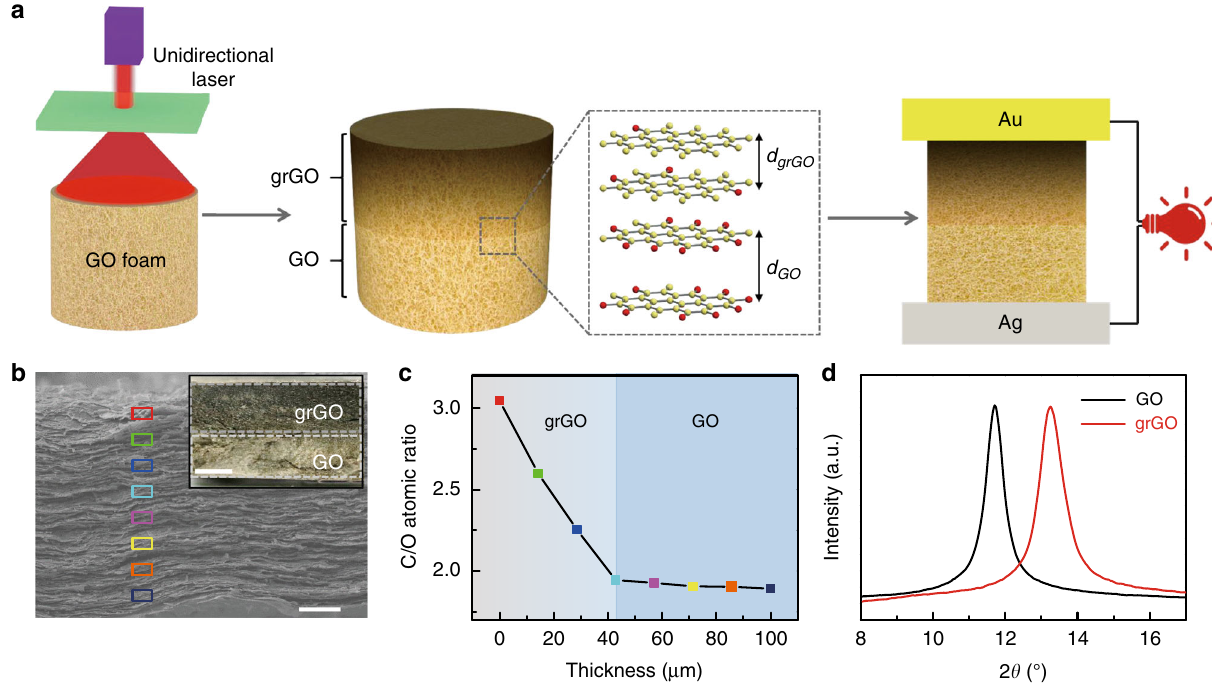
Fig. 2 Preparation and characterization of heterogeneous graphene oxide. ( a ) Schematic illustration of the preparation process of heterogeneous graphene oxide (h-GO)-based hygroelectric generator (HEG). h-GO is composed of gradient reduced graphene oxide (grGO) with compact interlayer spacing and graphene oxide (GO). ( b ) Cross-sectional scanning electron microscopy (SEM) image of h-GO. Inset b is the sectional-viewed optical image of h-GO. Scale bars: b , 20 μ m; inset, 0.2 mm. ( c ) Energy-dispersive spectroscopy (EDS) along the transversal direction of h-GO indicates a chemical C/O ratio gradient within the grGO, while a nearly constant C/O ratio through the GO region. ( d ) X-ray diffraction (XRD) pattern of top side (grGO) and bottom side (GO) of